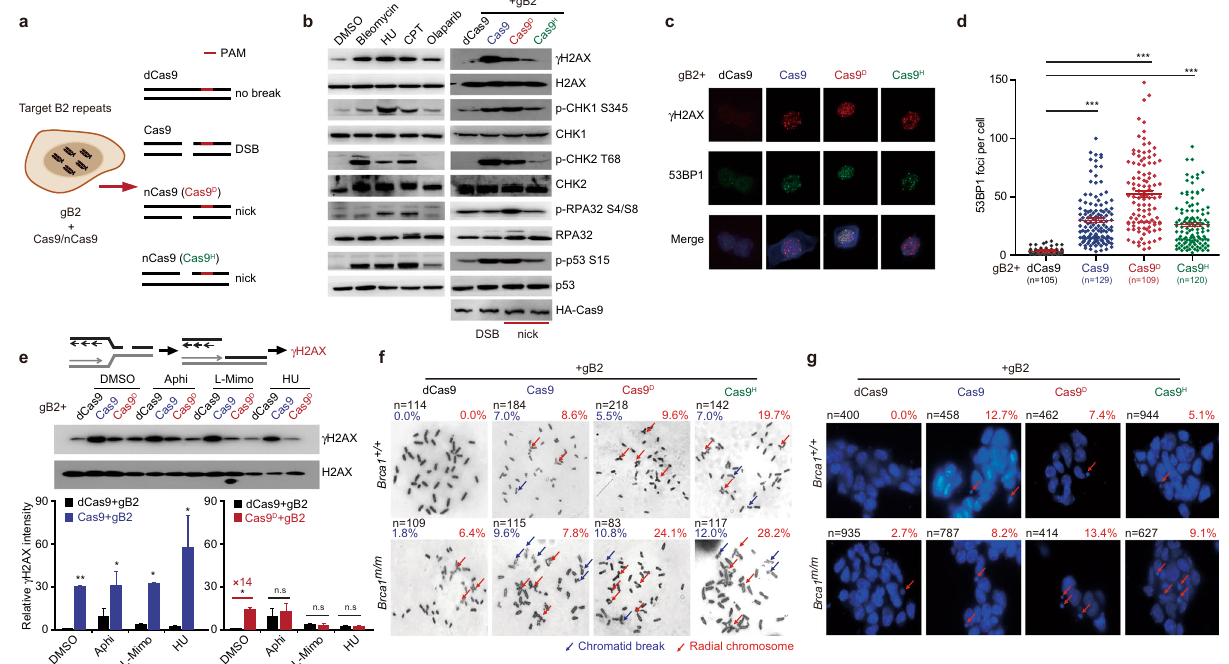
Fig. 1 | Nicks induce increased chromosomal aberrations in Brca1 -de fi cient cells.a SchematicofDSBandnickinductionatshortinterspersed nuclearelement (SINE)B2repeatsbySpCas9nucleases.Cas9 D :Cas9D10A;Cas9 H :Cas9H840A.The PAM is highlighted by red line. b Immunoblot of mESC WCEs after 2-h treatment with DNA damage-inducing agents or 24h after transfection with expression plasmids for dCas9-gB2, Cas9-gB2, Cas9 D -gB2, and Cas9 H -gB2. Transfection ef fi - ciencies were similar at about 70%. c Representative images of 53BP1 and γ H2AX focus formation in mESC at 24h after transfection with expression plasmids for dCas9-gB2, Cas9-gB2, Cas9 D -gB2 and Cas9 H -gB2 as indicated. d Quanti fi cation of 53BP1 foci in c . Each dot represents the number of 53BP1 foci in each cell. e Immunoblot of mESC WCEs for γ H2AX induction at 24h after transfection with dCas9-gB2,Cas9-gB2,Cas9 D -gB2,andCas9 H -gB2togetherwithreplicationinhibitor treatment. Top: Schematic of possible DSB induction and γ H2AX generation. Middle: Immunoblot of WCEs with anti- γ H2AX and anti-H2AX antibodies. Bottom: Quanti fi cation of γ H2AX intensity by Image J. f Representative images of